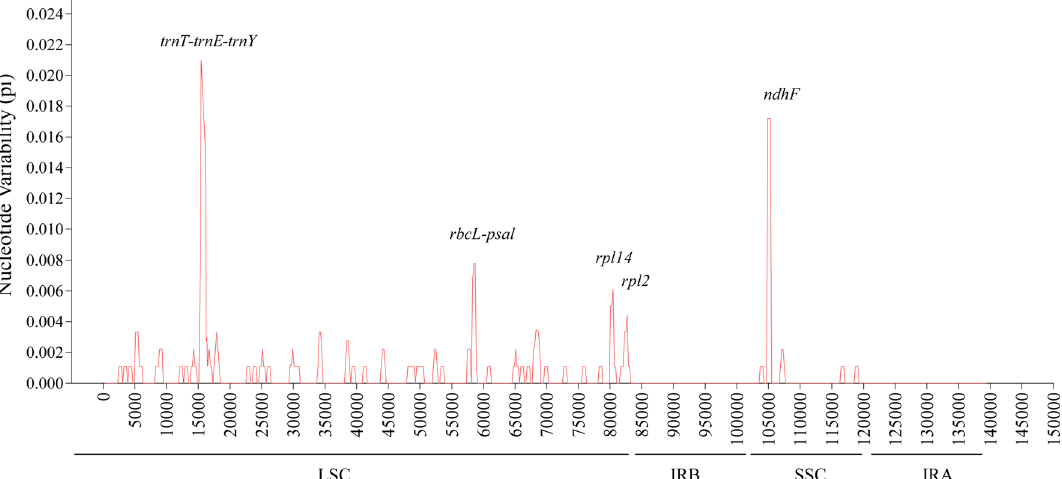
Figure 5. Sliding window analysis of Chimonobambusa genus complete chloroplast genome sequences. X-axis: position of the midpoint of a window, Y-axis: nucleotide diversity of each